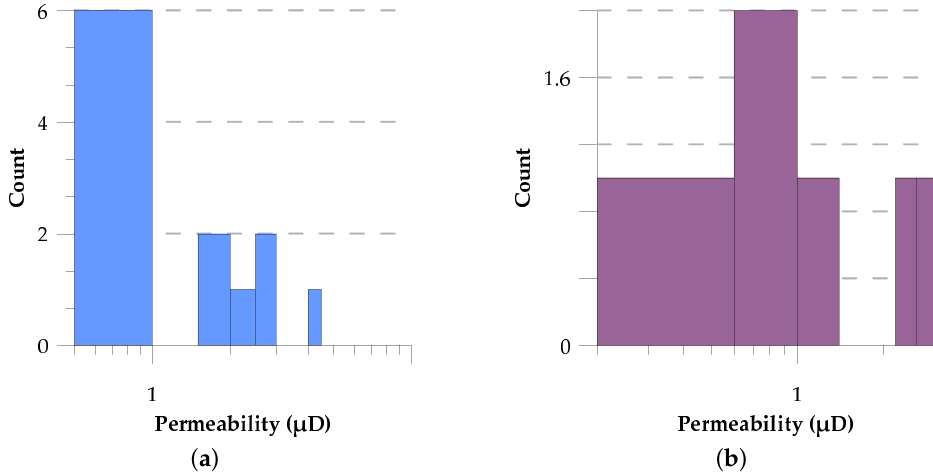
Figure 4. Permeability of received collection: ( a ) Ø100 × 200 mm whole cores; ( b ) Ø30 × 30 mm core plugs (courtesy of LUKOIL LLC, a priori